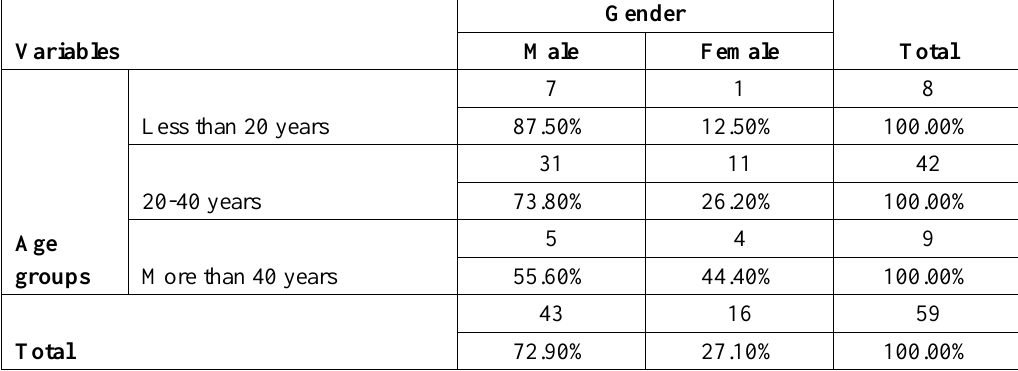
Table 2. Correlation between distribution of study sample according to gender and according to age.